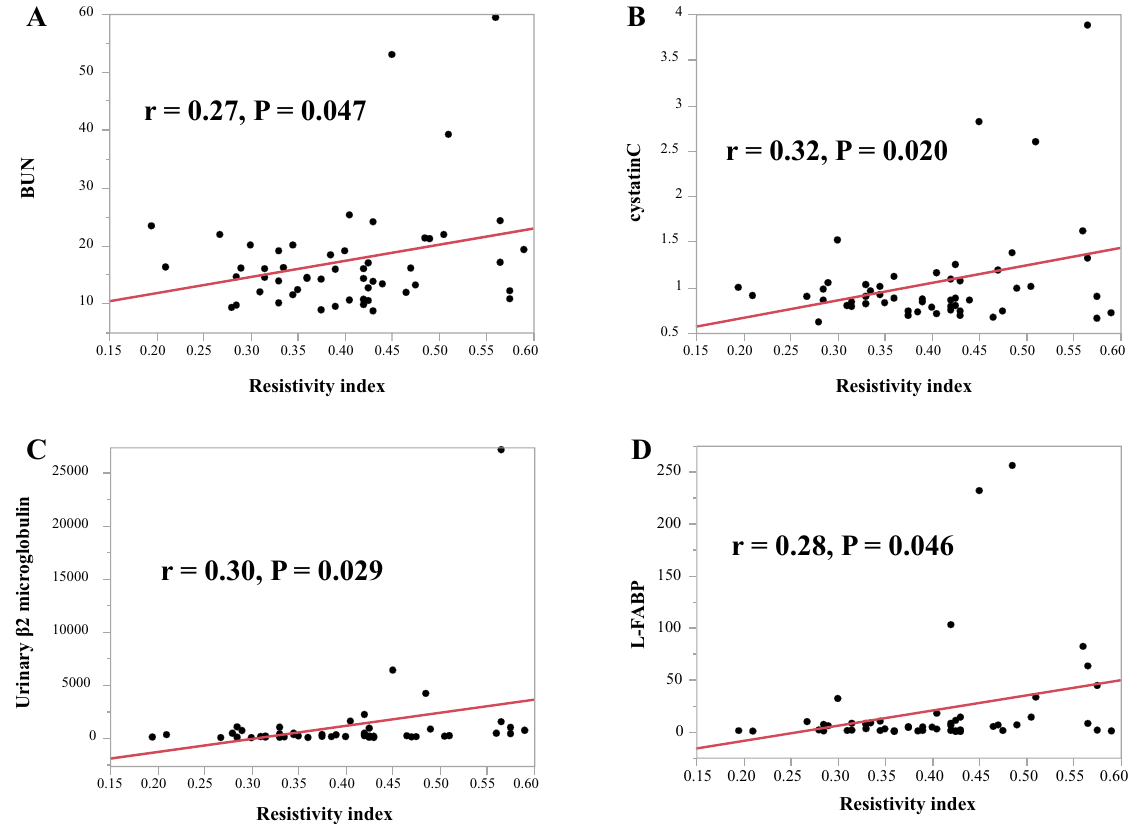
Figure 3. Correlation between the resistivity index and blood urea nitrogen (BUN) ( A ), cystatin C ( B ), Urinary β2 microglobulin ( C ), and liver-type fatty acid-binding protein (L-FABP) ( D ). The mean RI was positively correlated with blood urea nitrogen (BUN; r = 0.27, P = 0.047; A ), cystatin C (r = 0.32, P = 0.020; B ), urinary β2 microglobulin (U-β2MG, r = 0.30, P = 0.029; C ), and liver-type fatty acid-binding protein (L-FABP; r = 0.28, P = 0.046; D